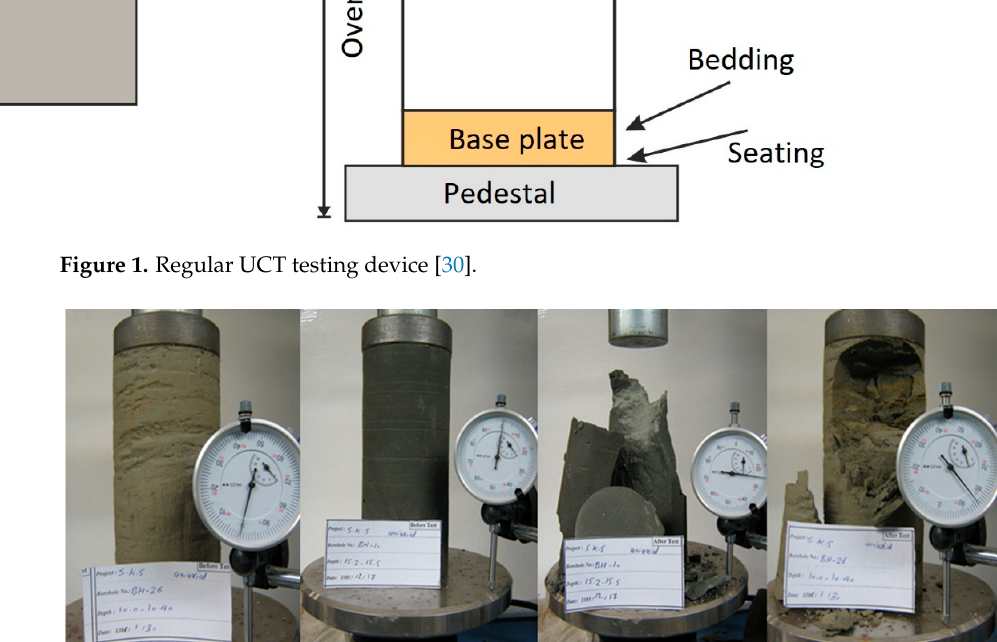
Figure 1. Regular UCT testing device [30].